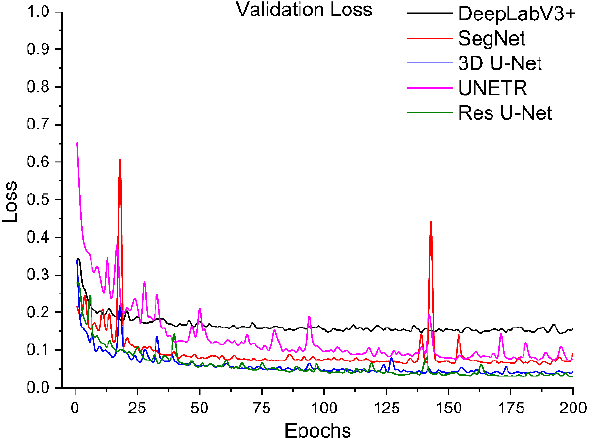
Figure 7. Training loss of segmentation networks trained independently.